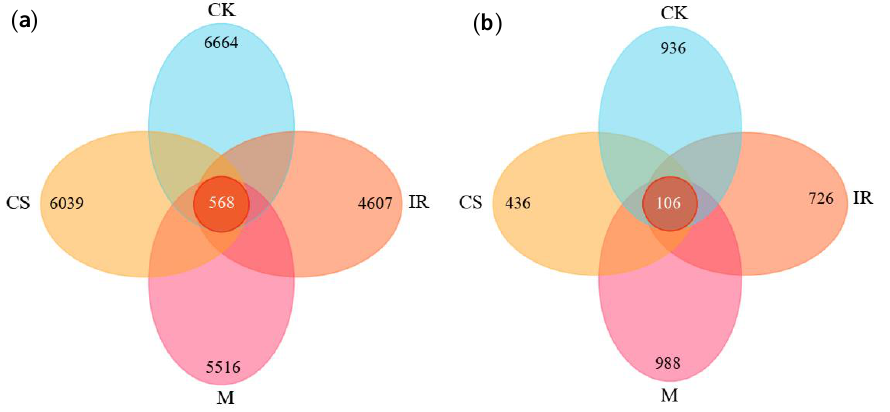
Figure 2. Venn diagram of bacterial and fungal sequences in different soil sample plots. ( a ) Bacteria; ( b ) fungi. IR, Italian Riesling; M, Merlot; CS, Cabernet Sauvignon; CK, control check (desert